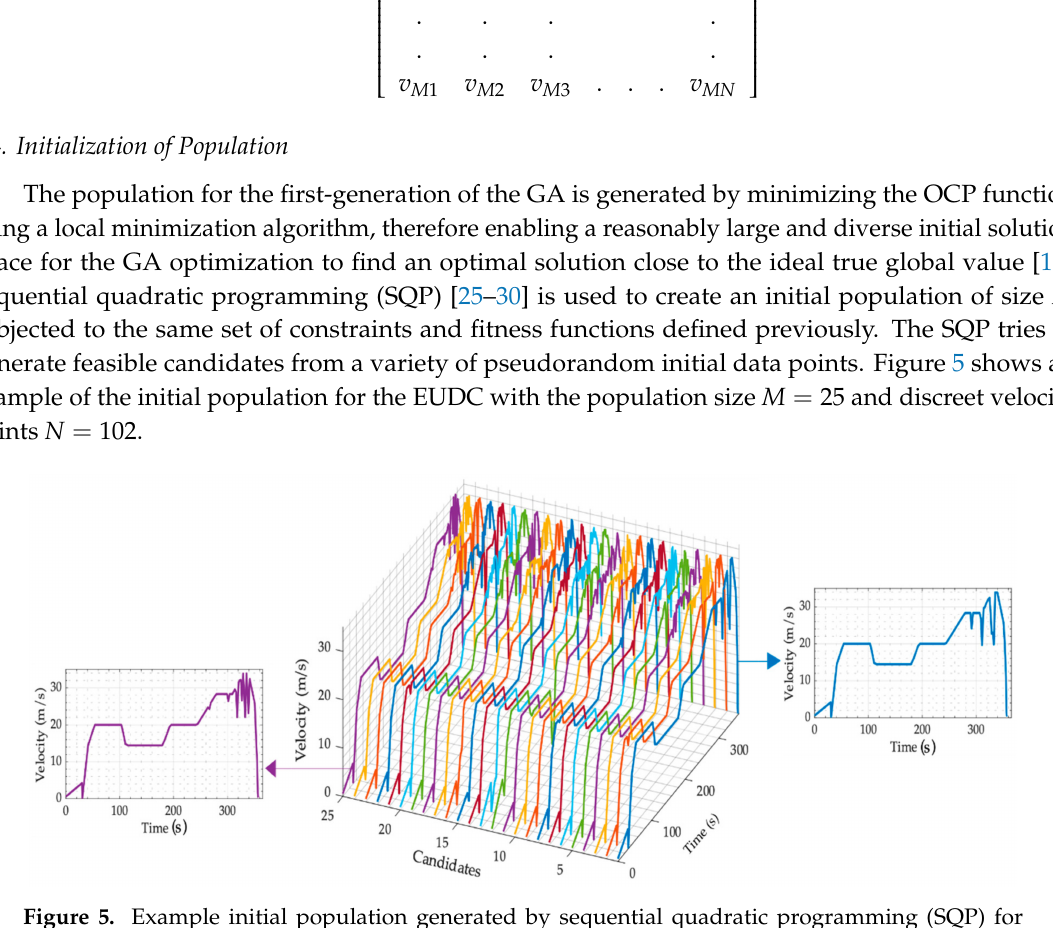
Figure 5. Example initial population generated by sequential quadratic programming (SQP) for the